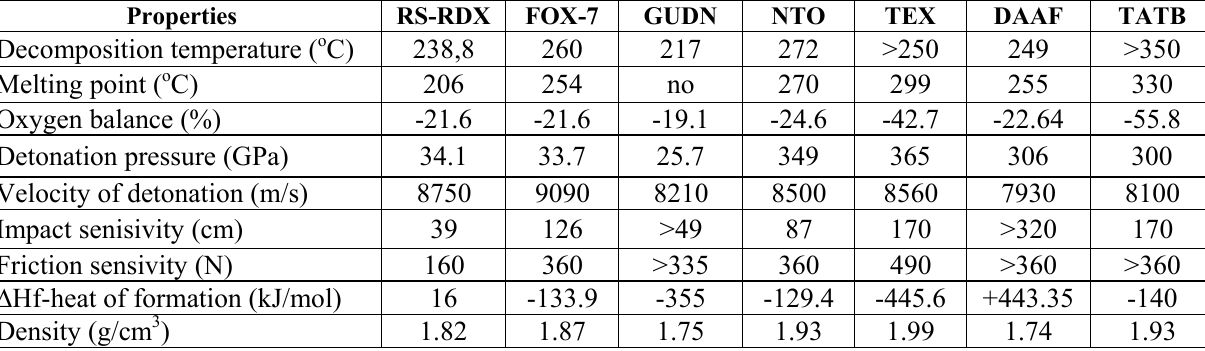
Table 3. Performance characteristics of explosive components and example formulations